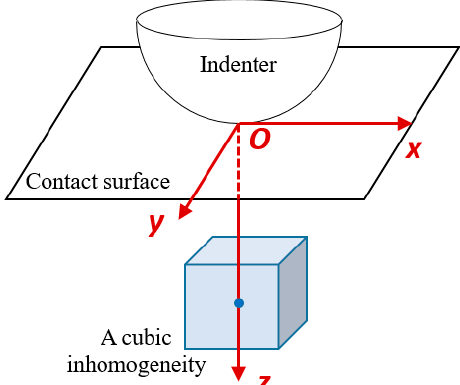
Figure 6. Schematic of the simple case for the efficiency validation.